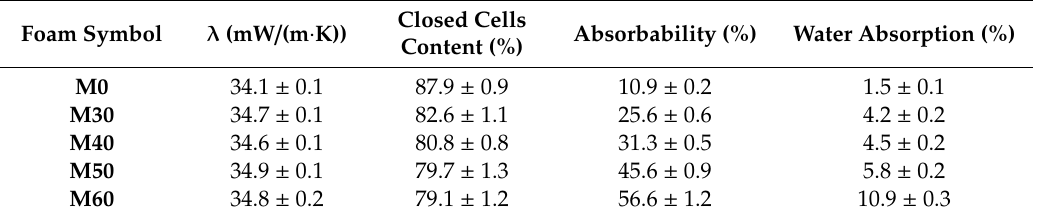
Table 4. Thermal insulation properties of RPU / PIR foams modified by rapeseed cake. Foam Symbol λ (mW / (m ·